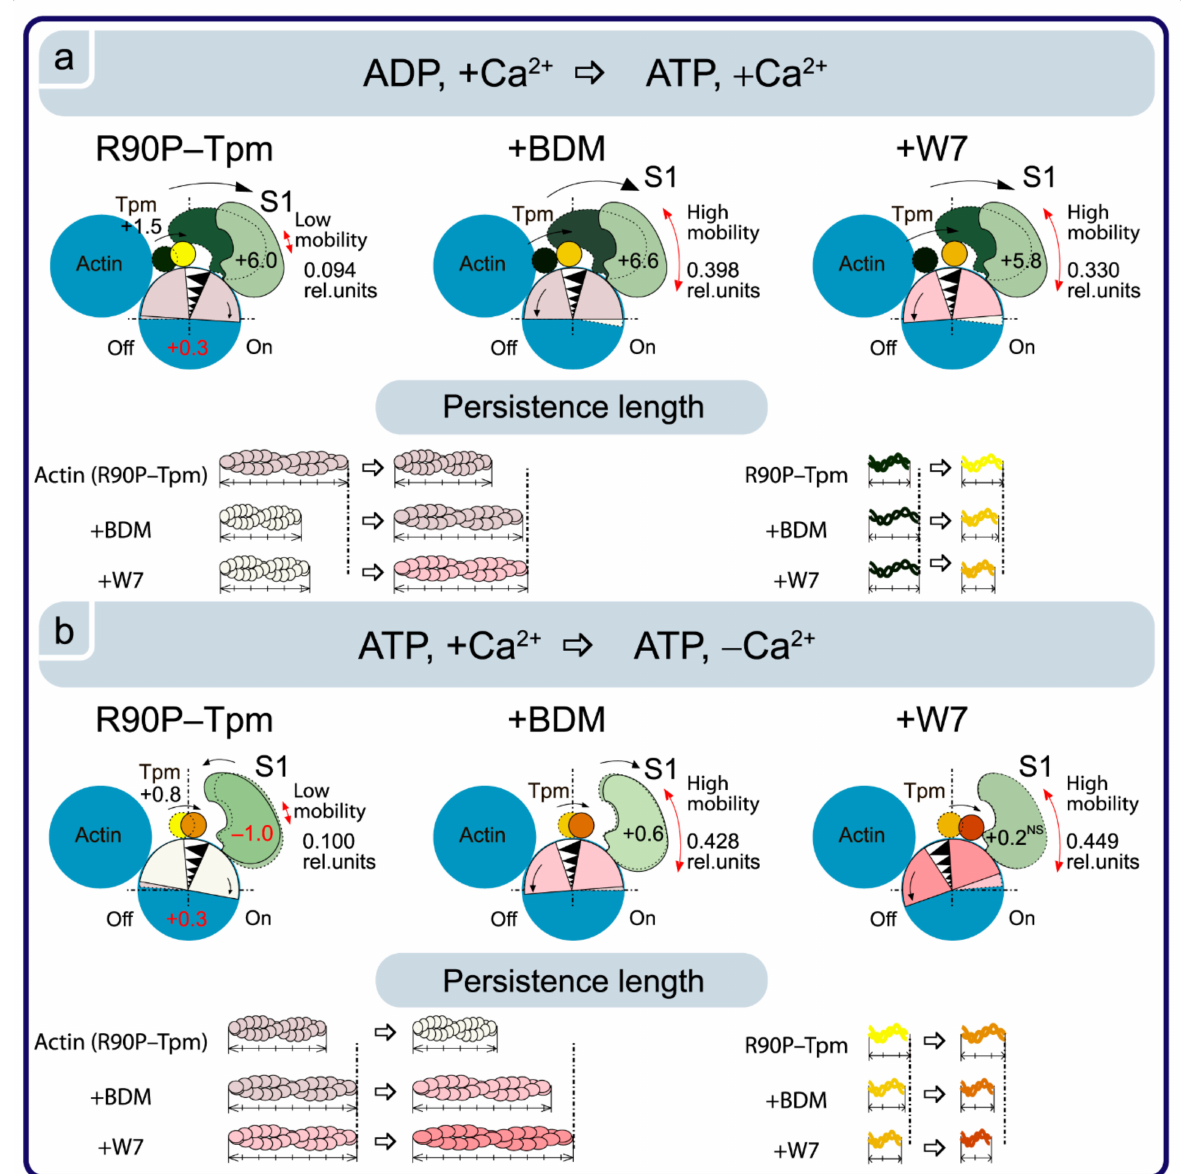
Figure 12. The effect of BDM and W7 on the changes in the R90P-Tpm position, in actin–myosin conformational rearrange- ments, and in the persistence lengths of the Tpm strands and actin filaments. The value for ε is the bending stiffness. The upper and bottom panels show the transition of the actin-Tpm-TN-S1 complex from the state in the presence of ADP at a high Ca 2+ to the state in the presence of ATP at a high Ca 2+ ( a ) and further to the state at a low Ca 2+ concentration ( b ). BDM stimulates the formation of strong myosin binding with actin in the presence of ADP and the formation of weak myosin binding with actin under the relaxing conditions. W7 does not affect the conformation of the myosin head at a high Ca 2+ , however, it allows for the weak binding of the myosin heads to actin in the presence of ATP at a low Ca 2+ . The mobility of the myosin heads is increased significantly in the presence of BDM and W7, as follows, from the changes in the number of disordered probes (parameter N). The changes in the actin rotation and in the Tpm position are derived from the data on the myosin conformational changes. BDM and W7 increases the persistence length of actin (drawn to scale), and decreases that of Tpm. The designations are the same as in Figure 5. The changes in Φ E for S1 upon transition between the states are shown by